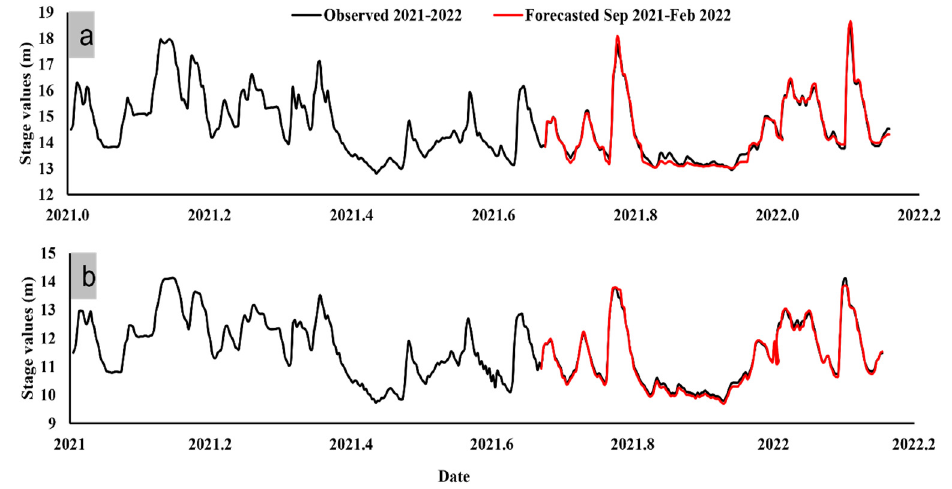
Figure 7. Combined observed and forecasted stage data for Chattahoochee ( a ) and Blountstown ( b ).